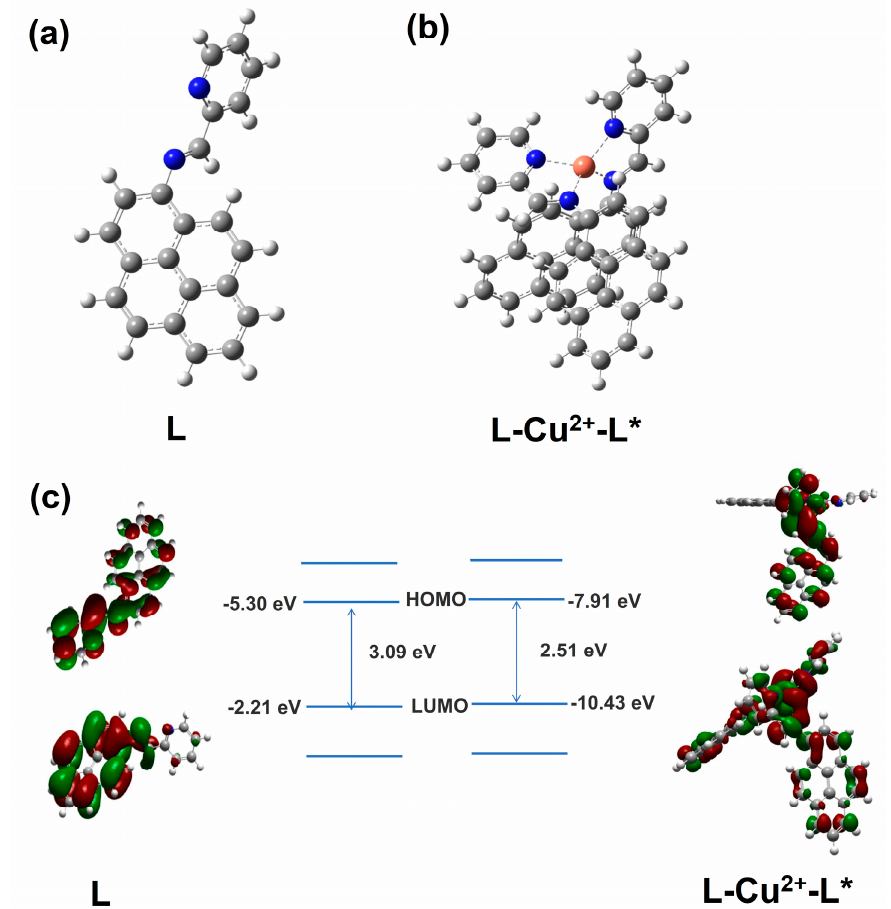
Figure 8. DFT optimized structures of ( a ) L and ( b ) L–Cu 2+ –L* excimer complex (black carbon; grey hydrogen; blue nitrogen and magneta Cu 2+ ) ( c ) HOMO, LUMO, and band gap of L and L–Cu 2+ –L* excimer complex.